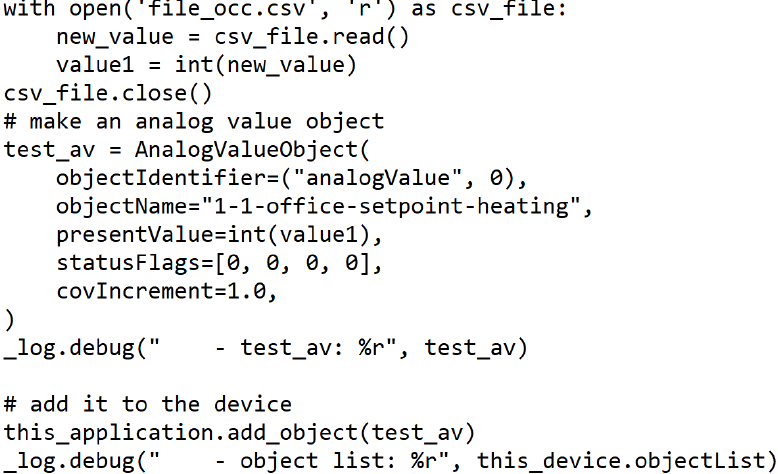
Figure 12. Read BACnet device’s properties using Python.